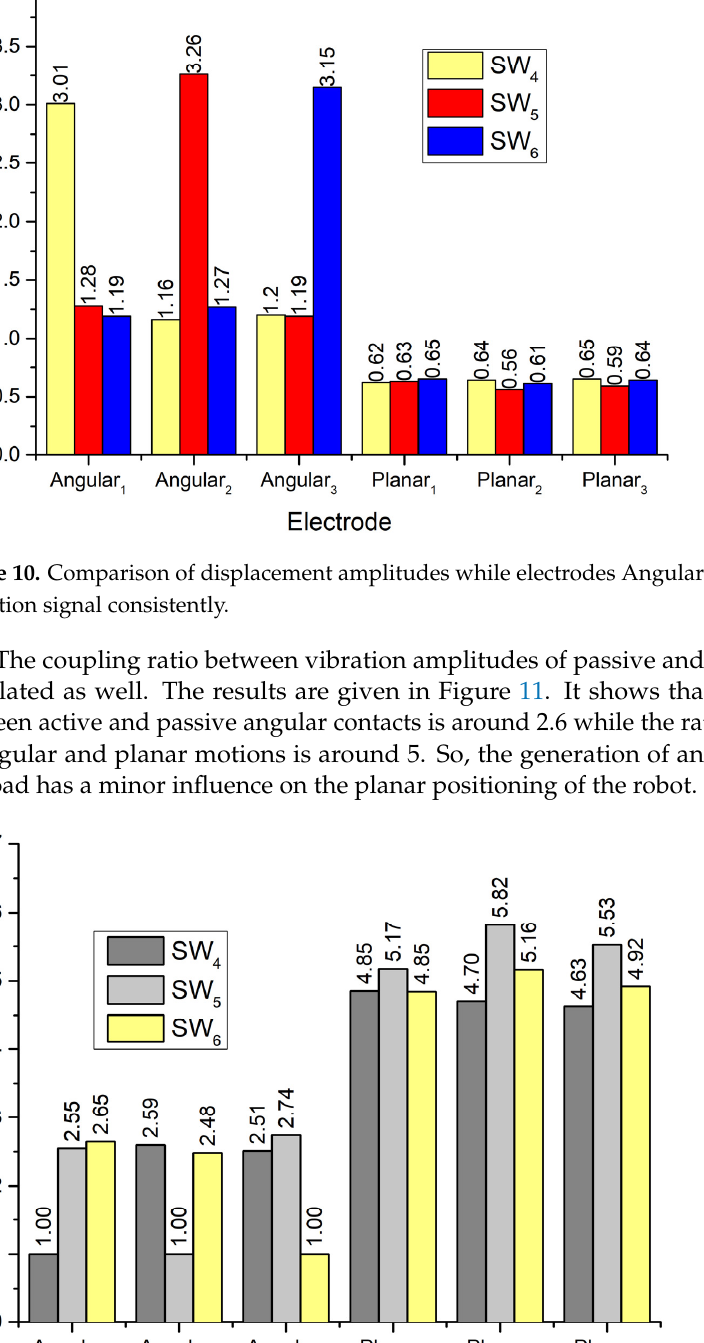
1 –Angular 3 are